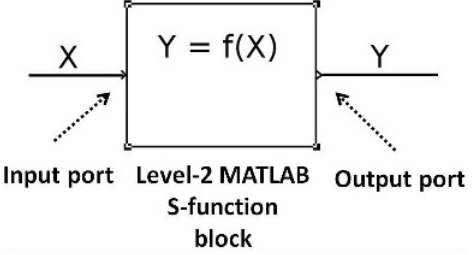
Fig. 1. Signal approach.